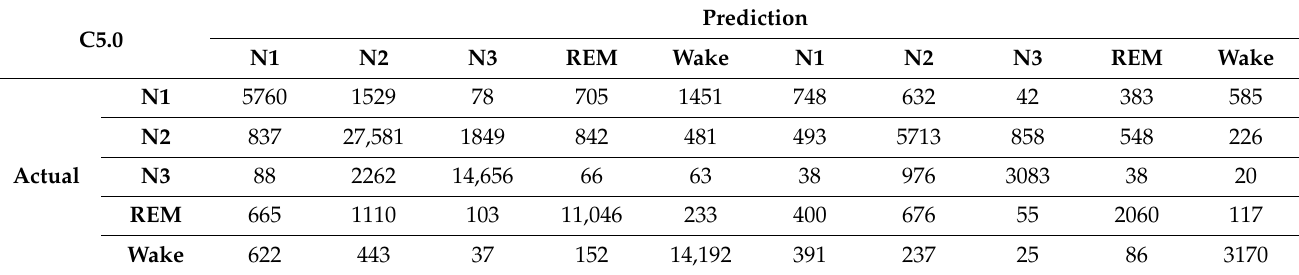
Table 4. Confusion matrix of the C5.0 Model using training and testing datasets for the classification of EEG features of the sleep stages W, N1, N2, N-3, and R.